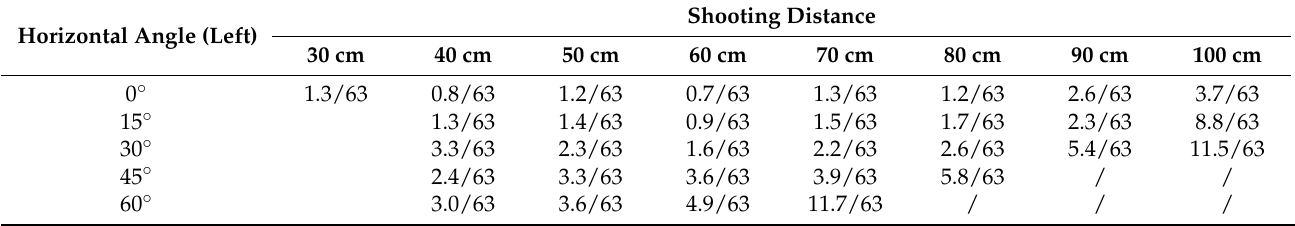
Table 9. Average EBR with different shooting